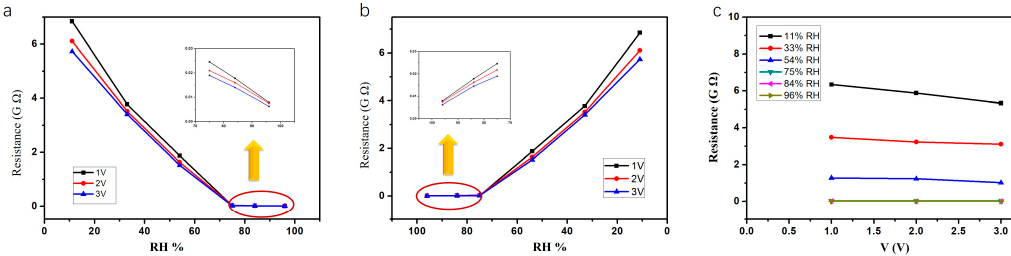
Figure 4. Plot of resistance response of SnO 2 nanostructures with humidity from 11% to 96% ( a ), and from 96% to 11% ( b ). ( c ) The R-V curves of the SnO 2 nanostructure with different RHs.